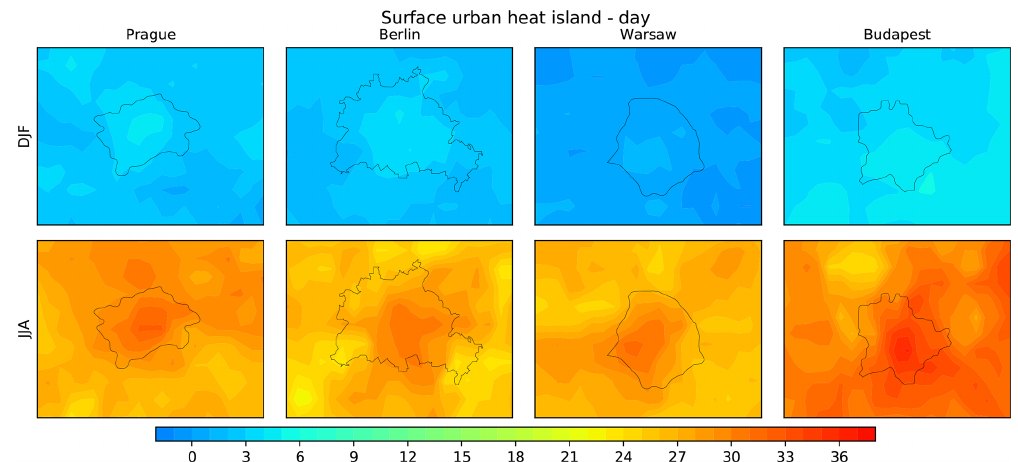
Figure 8. Satellite-based daily winter and summer surface temperatures ( ◦ C) around Prague, Berlin, Warsaw and Budapest (includes 10:00 and 12:00UTC satellite data).